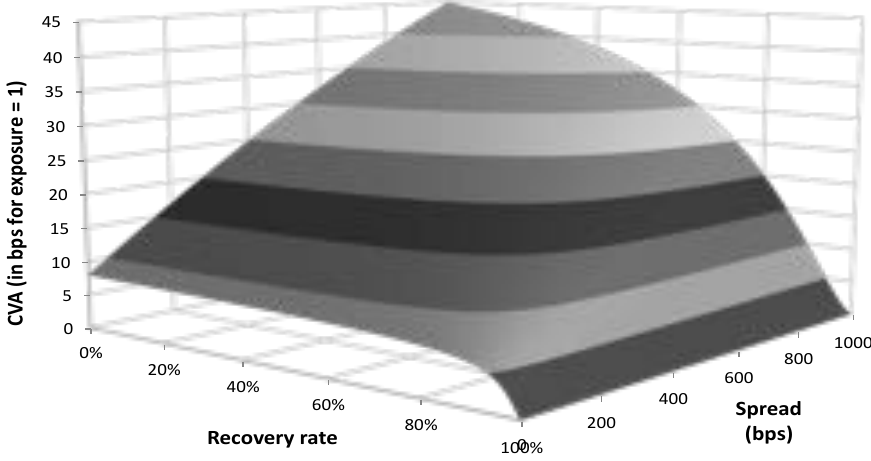
in credit spreads and all recovery